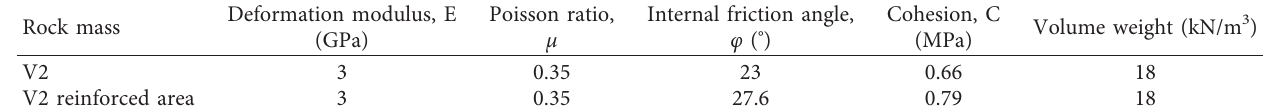
Table 2: The physical and mechanical parameters of the rock mass.